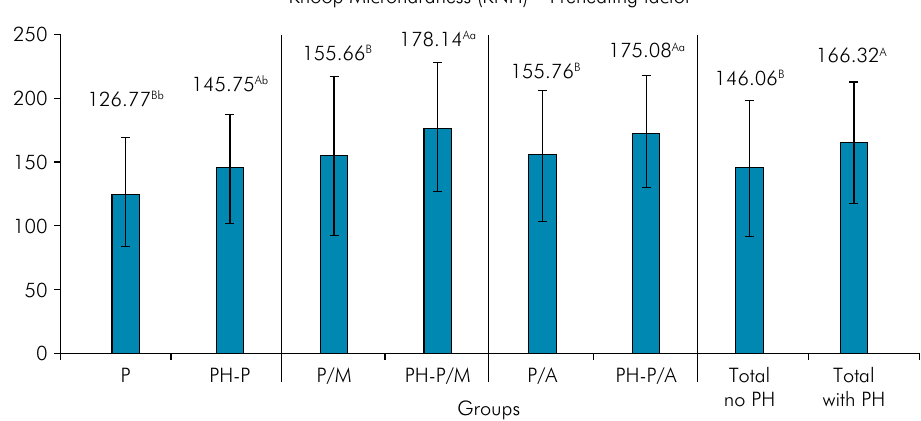
Figure 3. Results of knoop microhardness for preheating.